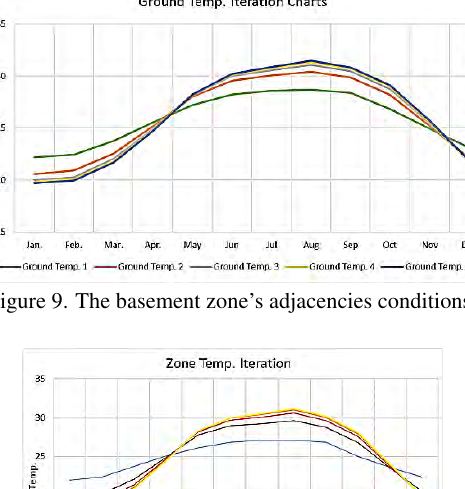
on the underground